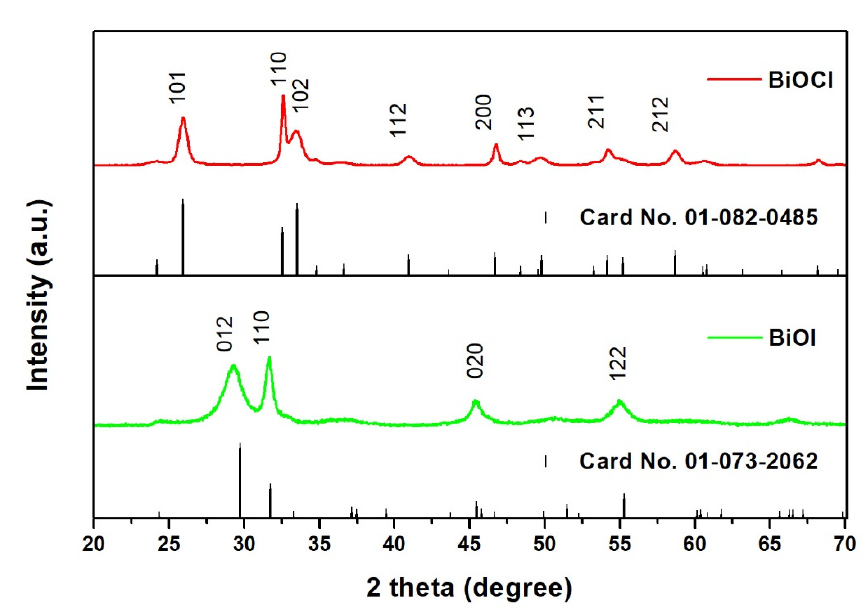
Figure 1. XRD di ff raction pattern of BiOCl and BiOI photocatalysts. Figure 1. XRD diffraction pattern of BiOCl and BiOI photocatalysts.